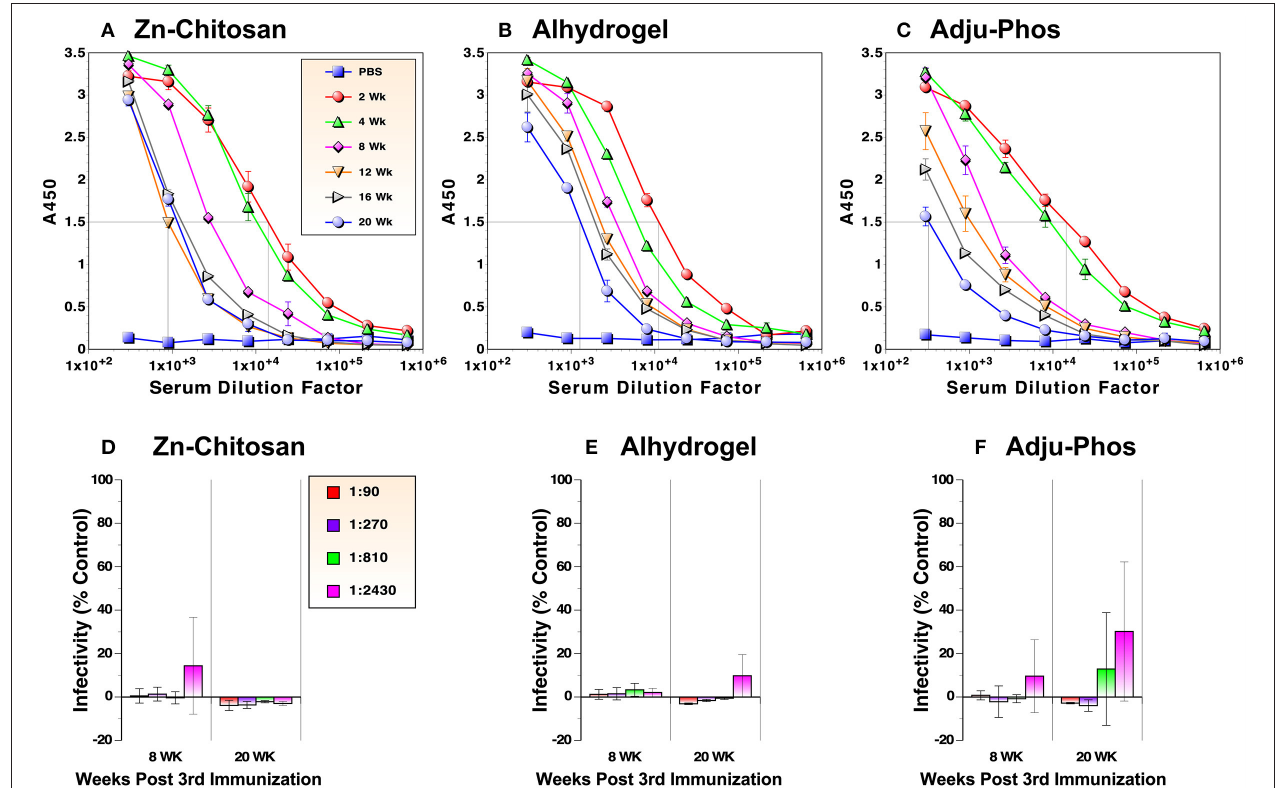
FIGURE 5 | Durability of antibody responses against the RBD. RBD-binding antibody levels were monitored by ELISA in duplicate (A–C) . Antiviral activity was assessed by neutralization assays against live, infectious SARS-CoV-2 in triplicate (D–F) . Time indicates weeks after the third immunization.